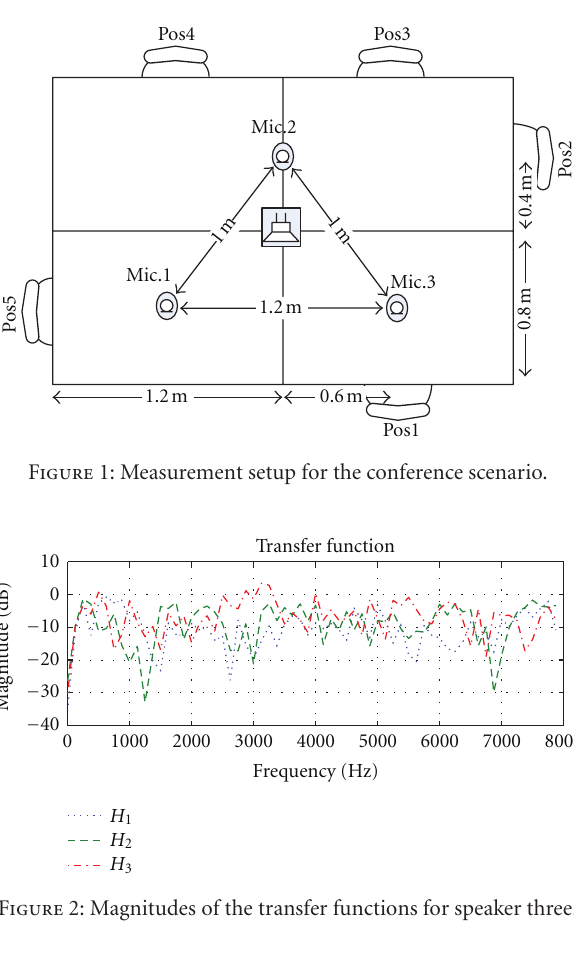
in Figure 1. The microphone distance was chosen 1.2 m for mic. 1 and mic. 3, and 1 m between the other